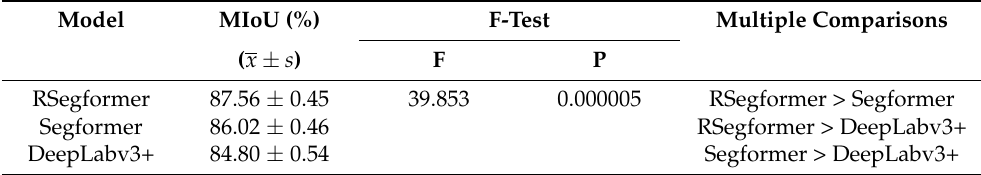
Table 5. One-way analysis of variance results for different